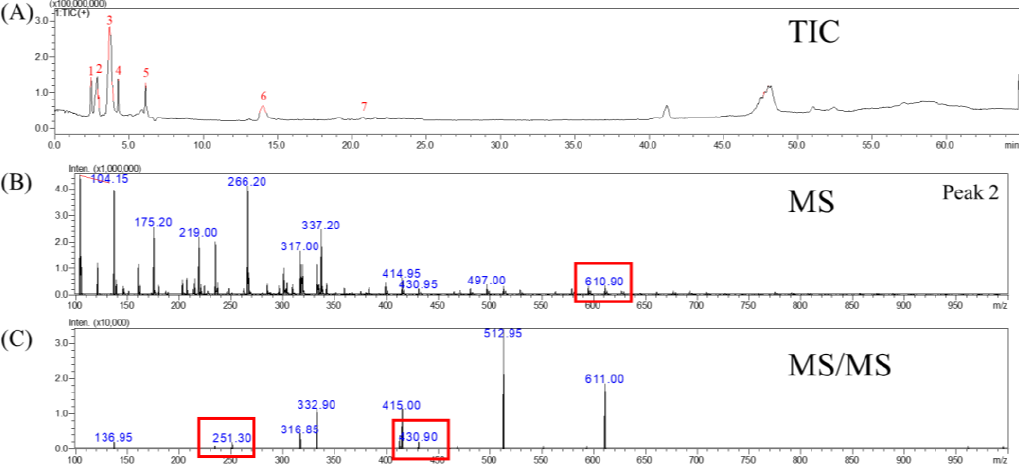
Figure 2. The mass spectrometry of ( A ) total ion chromatogram (TIC), ( B ) MS spectra, and ( C ) MS/MS spectra of the molecule under positive ion mode at m / z 610.90 from the untreated radish.